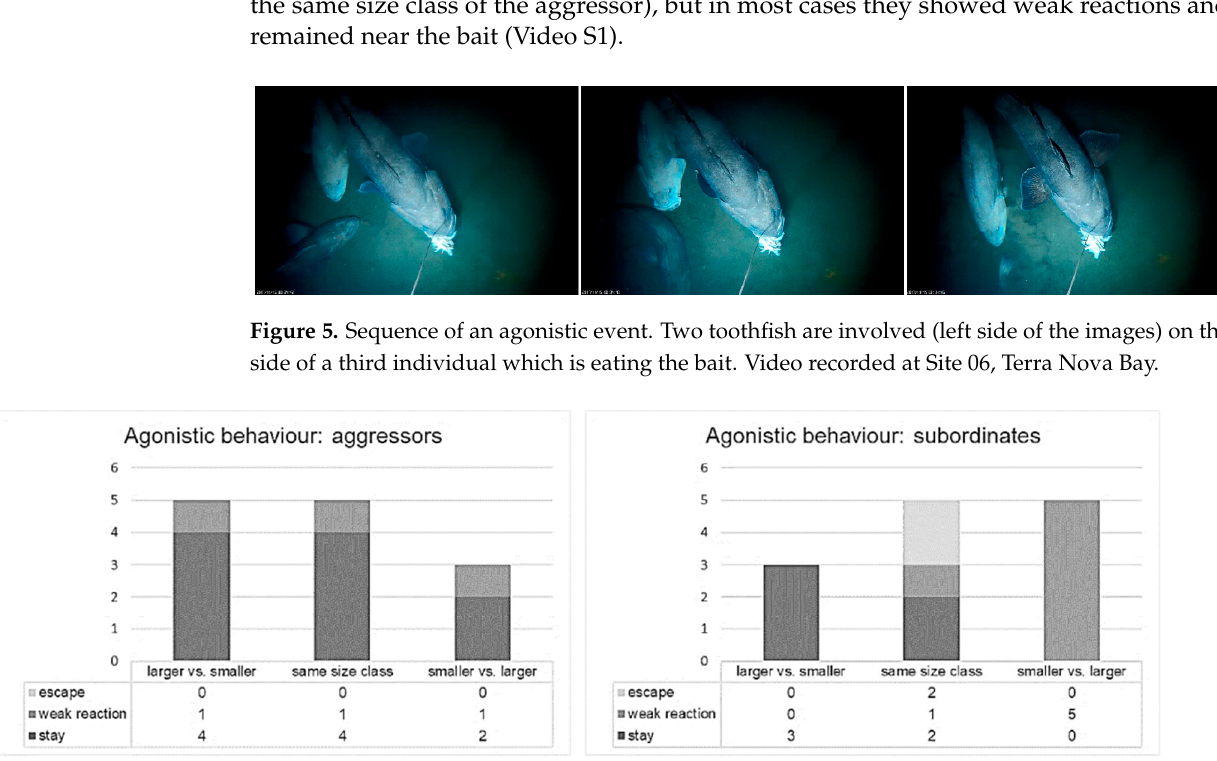
Figure 6. Reaction of aggressors and subordinates in the 13 recorded agonistic events, according to the size of the involved individuals.